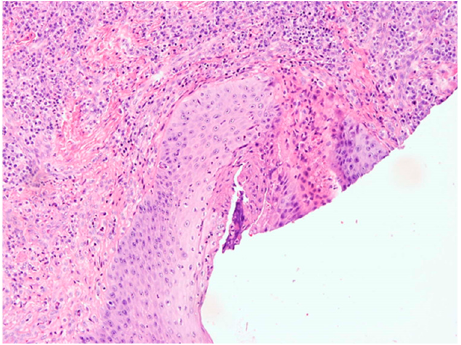
Figure 4. A cystic section with a squamous lining with a massive mixed-cell inflammatory infiltrate composed of lymphocytes, plasma cells, with an admixture of neutrophilic and eosinophilic granulocytes. H + E staining.